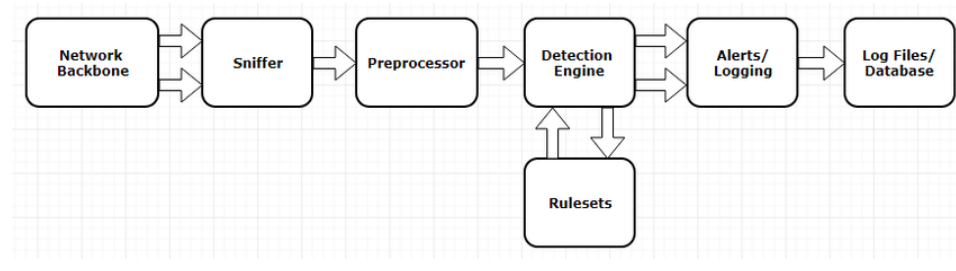
Figure 6. Snort architecture: Snort is a packet sniffer. However, it is designed to take packets and process them through the preprocessors. Each packet observed on the network is first passed through a set of preprocessors, which may extract information and/or modify the packet, and then check those packets against a series of rules (through the detection engine). Then, detection plugins match the packet against signature conditions. If a match was found, the information is sent through the alert system.